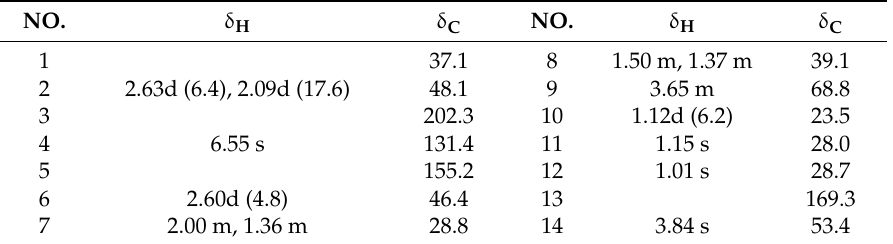
Table 1. 1 H-NMR (400 MHz) and 13 C-NMR (100 MHz) Spectral Data of Compound 1 in Methanol- d 4 ( δ in ppm, J in Hz).